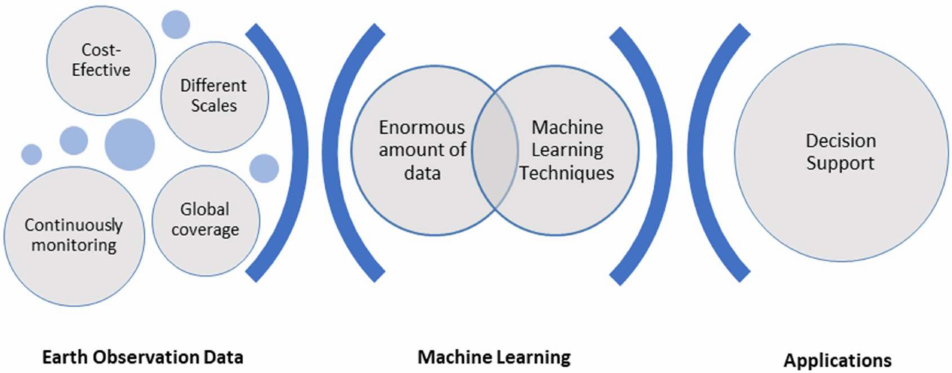
Figure 1. Overview of a decision support system based on machine learning techniques and Earth observation